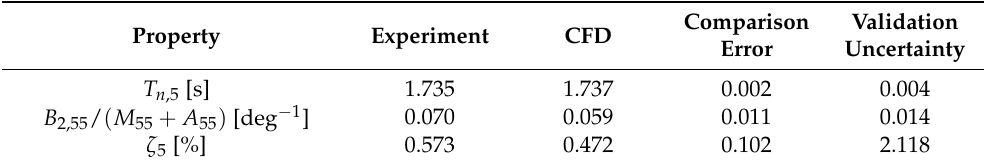
Table 7. Comparison of the free decay test results for pitch from experiments and CFD simulations using the quadratic method.